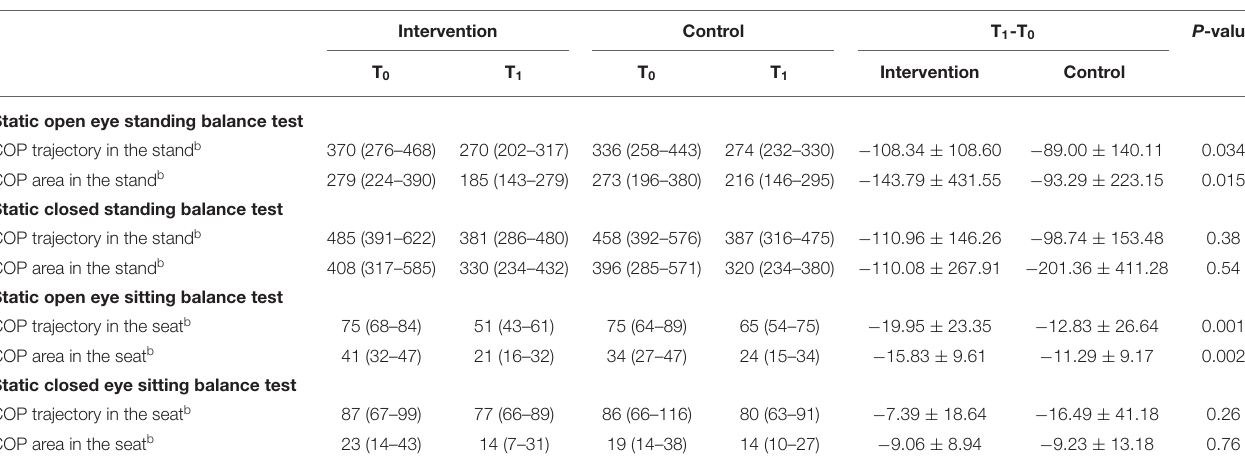
TABLE 4 | A comparison of static balance